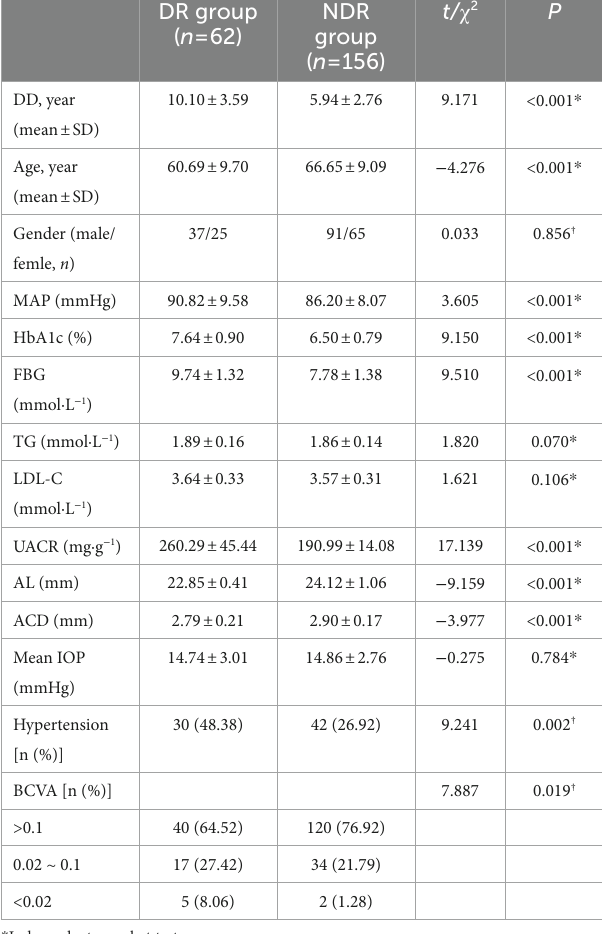
TABLE 1 Comparison of various clinical parameters between the DR group and the NDR group.